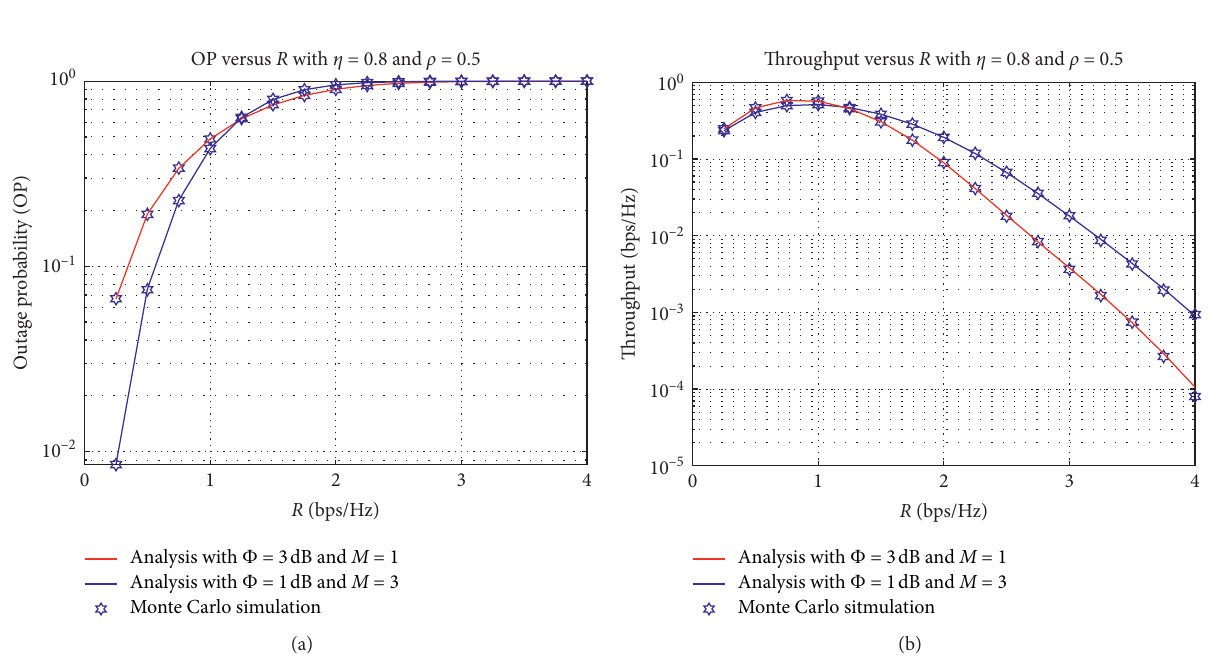
Figure 6: OP and IP versus R